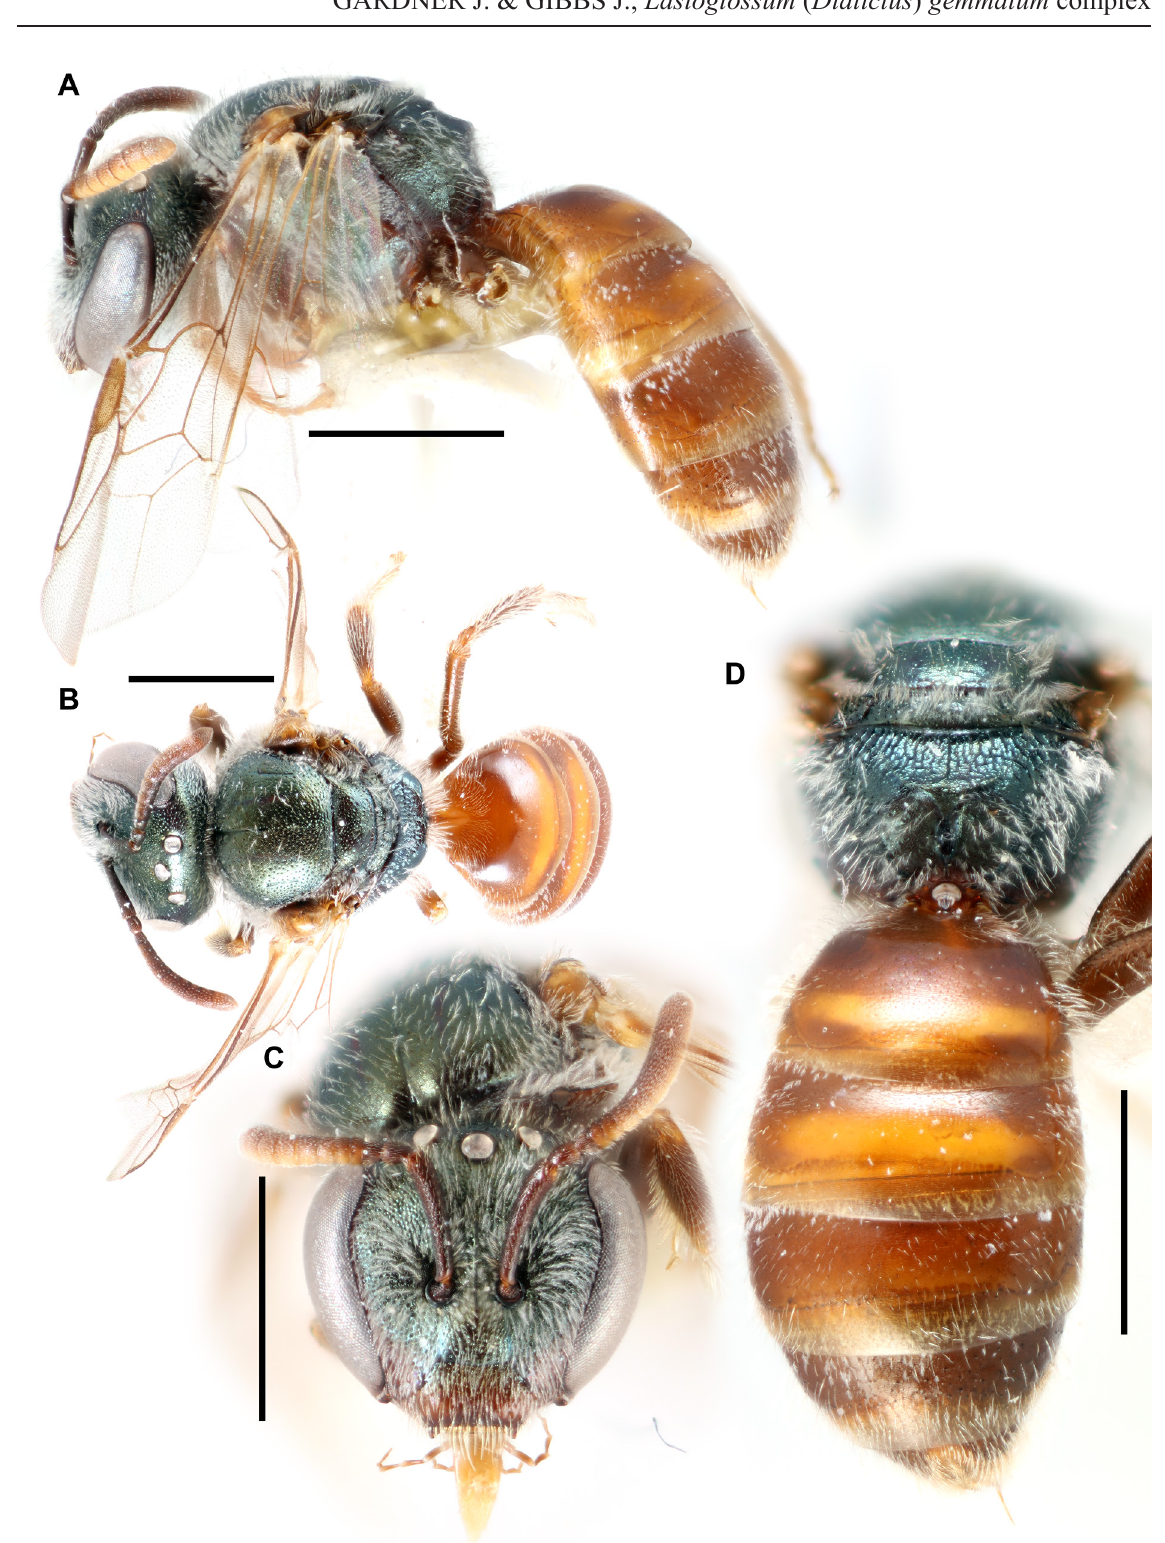
Fig. 67. Lasioglossum ( D .) surianae (Mitchell, 1960), ♀ (PCYU). A . Lateral habitus. B . Dorsal habitus. C . Face. D . Metasoma and propodeum. Scale bars = 1